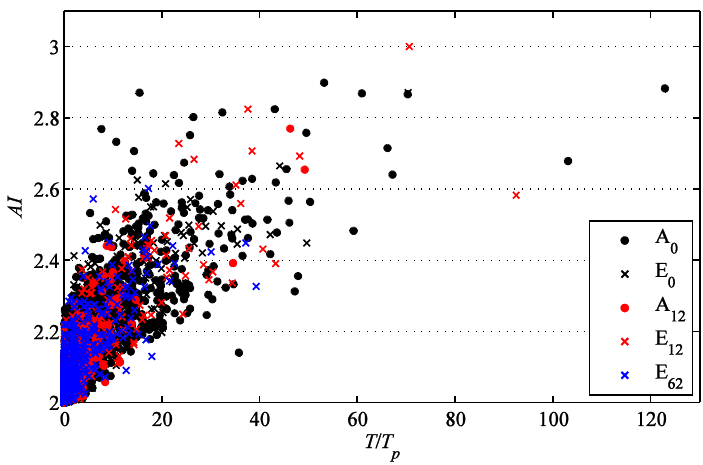
Figure 4. Dependence between the rogue event lifetimes T and the amplification factor AI , m =